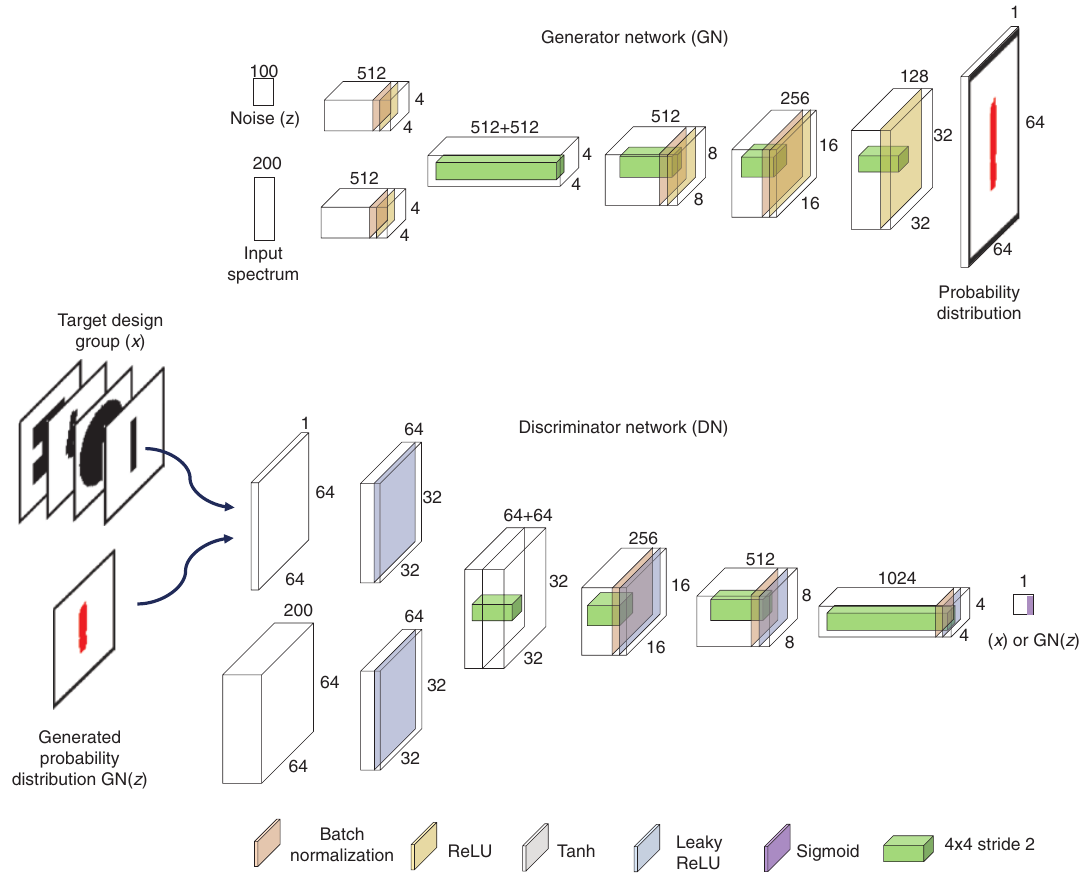
Figure 2: Schematic of the cDCGAN architecture to suggest the designs of structures. GN is composed of a transposed CNN to generate the structural images, and DN is composed of conventional CNN to distinguish target structural designs from the generated designs. Each layer introduces nonlinear activation functions (ReLU, Tanh, Leaky ReLU, and Sigmoid) according to the guideline of Radford et al.